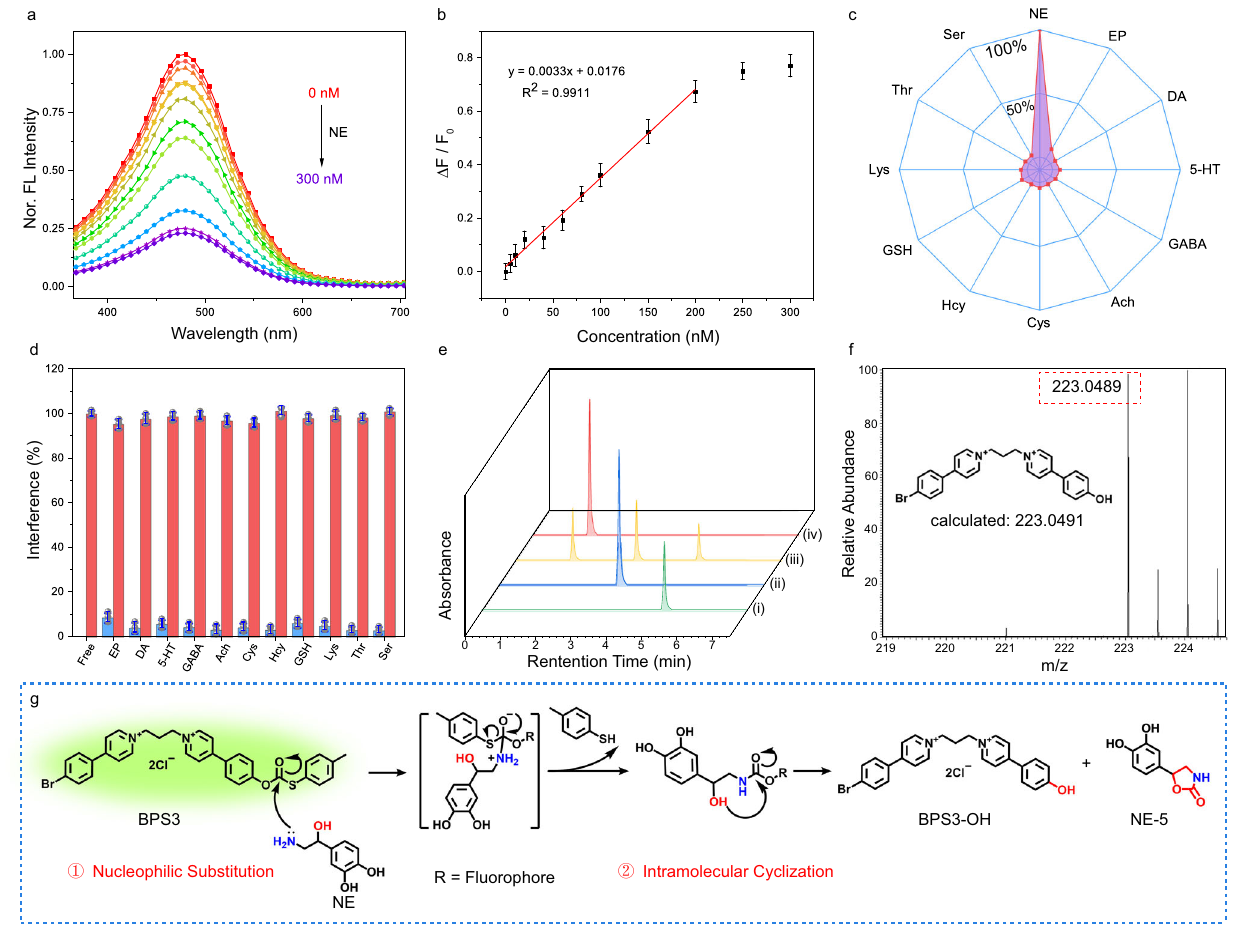
Fig. 2 | Sensing performances and mechanism. a Fluorescence spectrum of BPS3 (5 μ M) upon addition of NE (0 – 300nM),two-photon excited at 720nm. b Plot and linear fi tting of the fl uorescence variation rates ( Δ F/F 0 ) at 480nm versus the con- centration of NE (0 – 300nM). Data are presented as mean±S.D. Error bars: S.D., n =3independentexperiments. c Selectivityand( d )competitiontestsoftheprobe BPS3towardNEagainstotherneurontransmittersandaminoacids(norepinephrine (NE), epinephrine (EP), dopamine (DA), serotonin (5-HT), γ -aminobutyric acid (GABA),acetylcholine(Ach),cysteine(Cys),homocysteine(Hcy),glutathione(GSH),